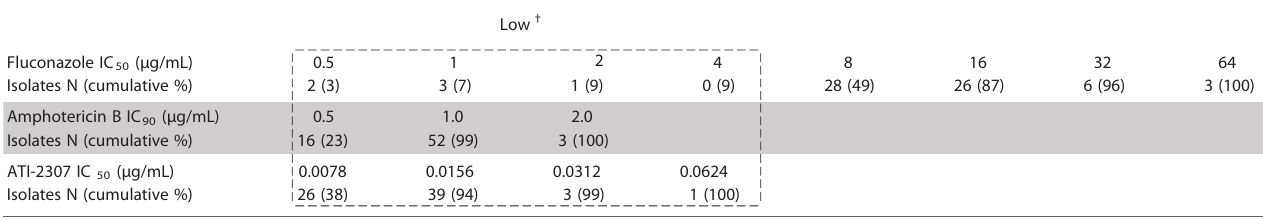
TABLE 1 | Fluconazole and ATI-2307 IC 50 , and amphotericin B IC 90 values, for high IC 50 fl uconazole Cryptococcal neoformans clinical